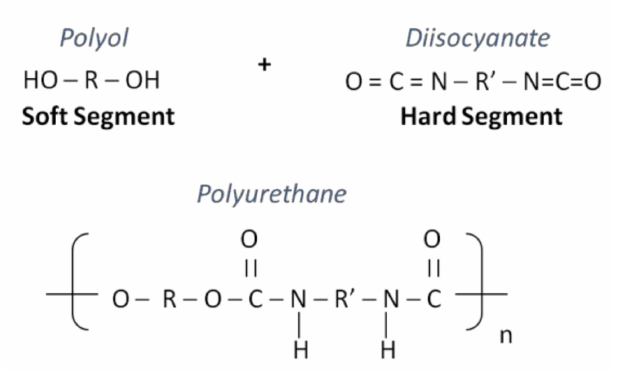
Figure 1. Polyurethane chemical